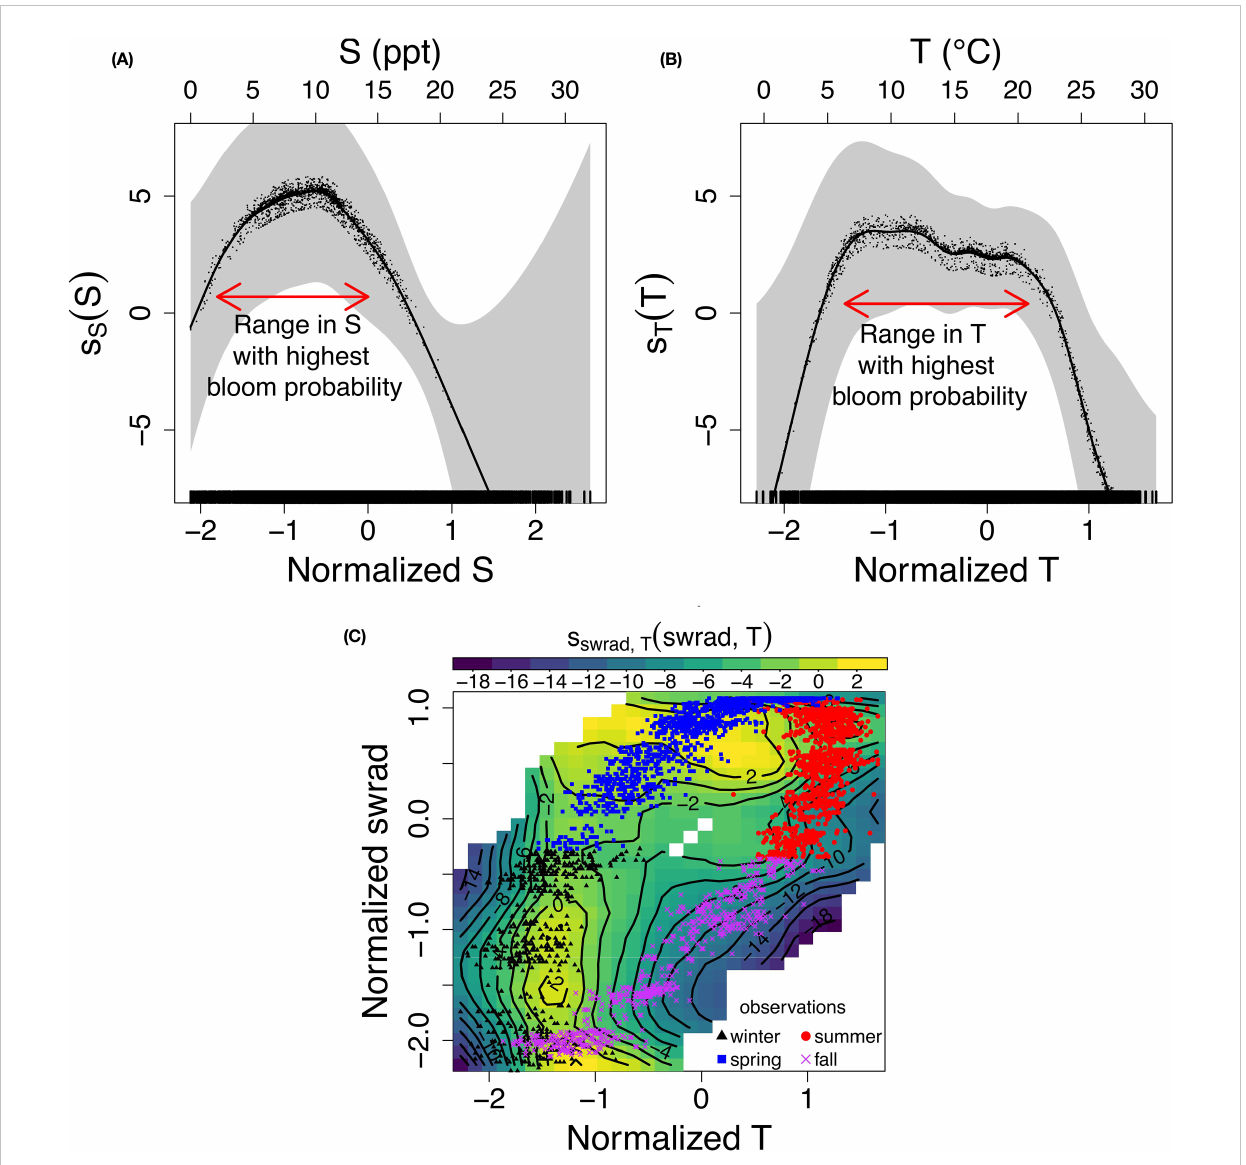
FIGURE 5 (A – C) Nonlinear response of (the logit of) the probability of a P. minimum bloom to (normalized) (A) salinity (S), (B) water temperature (T), and (C) interacting (normalized) T and solar irradiance (swrad), and the corresponding observations assuming a generalized additive model with interaction terms [Eq. (10)] and the optimal variable combination {T, S, pH, swrad,